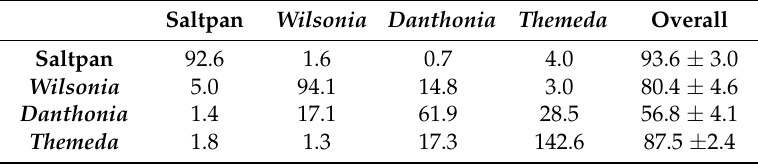
Table A8. Mean confusion matrix for WorldView-2 three-class classification results. Confusion values are given as a count value, and overall accuracies as a percentage with standard